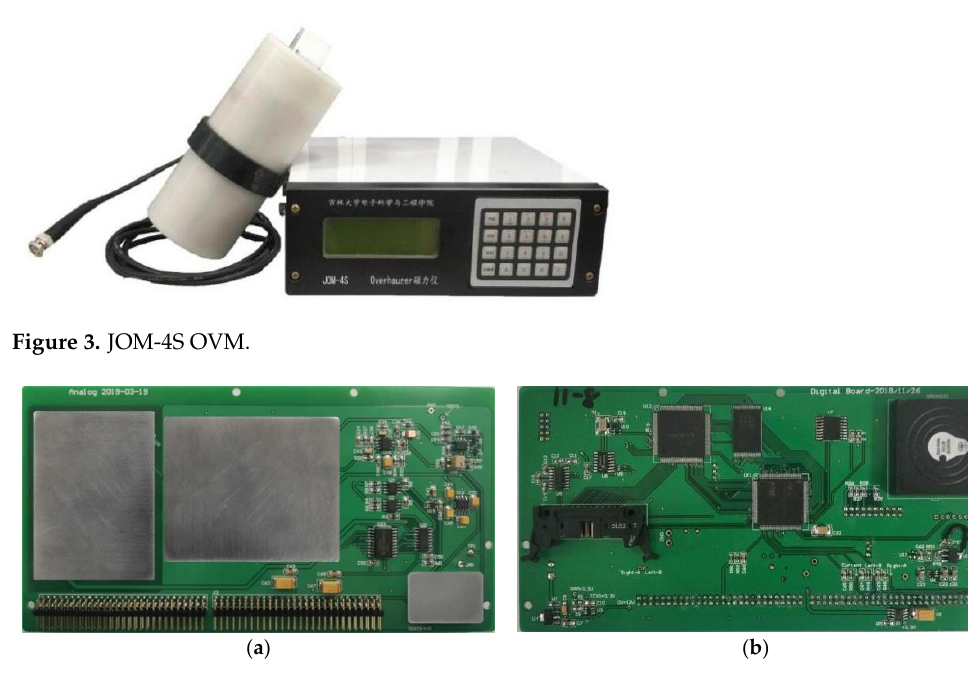
Figure 4. Analog board ( a ) and digital board ( b ) of JOM-4S OVM.